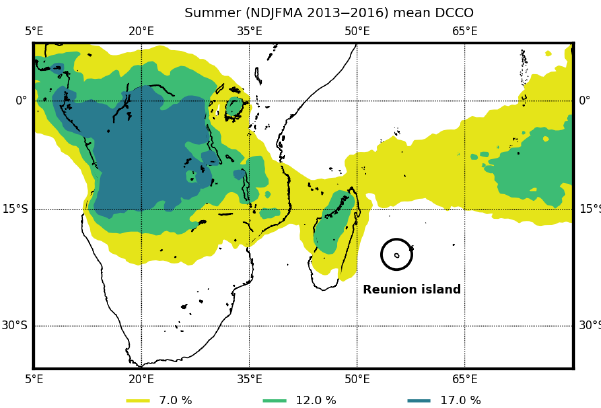
Figure 2. Average map of the deep convective cloud occurrence (DCCO) for austral summer conditions (NDJFMA from Novem- ber 2013 to April 2016). The yellow contour is for DCCO>7%, the green contour is for DCCO>12% and the dark green contour is for